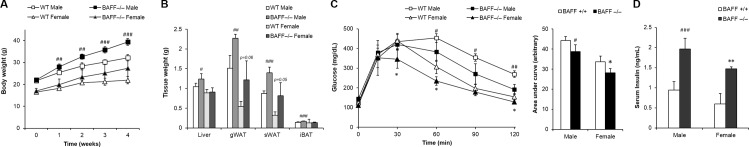
BAFF-/- mice display enhanced glucose tolerance under HF diet-fed conditions despite increased adiposity.BAFF-/- and wild-type C57BL/6J mice were fed a high-fat diet for 5 weeks. (A) Changes of body weight for 4 weeks of HFD feeding (n = 7~8). (B) Changes of tissue weight after 5-week HFD feeding (n = 7~8). (C) Glucose tolerances in after 4 weeks on HF diet (n = 6~7) and the area under the curve of GTT. The blood glucose levels were measured at 0, 15, 30, 60, 90 and 120 after intraperitoneal injection of glucose (2 g/kg). (D) Serum concentration of insulin quantified by ELISA. Serum sample was analyzed according to the manufacturer’s protocol. Data represent means ± SD. *p < 0.05 between female WT and female BAFF-/- mice. #p < 0.05, ##p < 0.01, and ###p < 0.001 between male WT and male BAFF-/- mice. gWAT: gonadal white adipose tissue, sWAT: subcutaneous white adipose tissue, iBAT: interscapular brown adipose tissue.